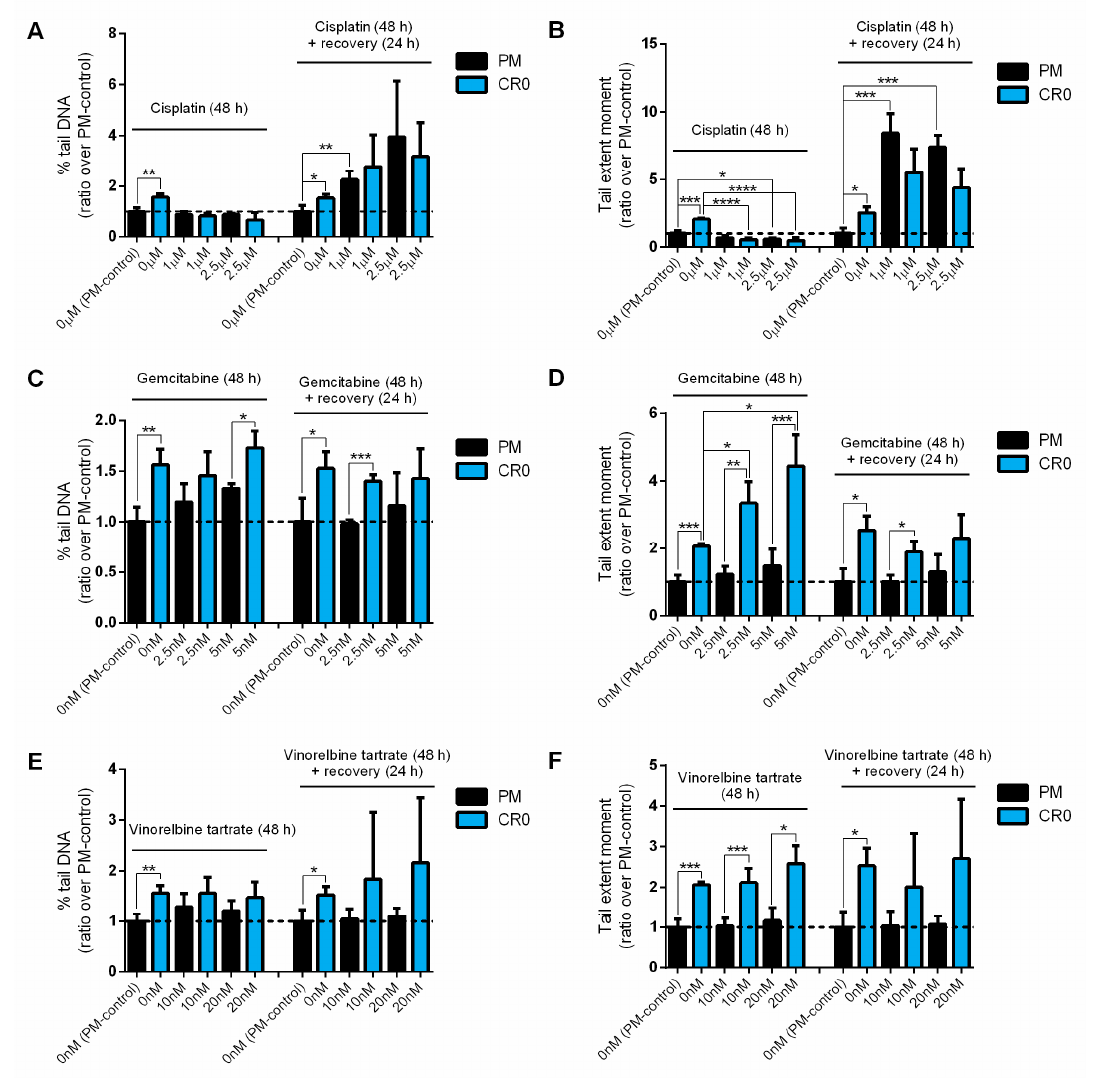
Figure 6. DNA damage and repair capacity of PM and CR0 cells exposed to selected chemotherapeutic drugs. Three drugs were tested: ( A , B ) cisplatin, ( C , D ) gemcitabine, and ( E , F ) vinorelbine tartrate. Cells were treated with two selected concentrations of the above chemotherapeutic drugs for 48 h and their DNA damages were measured by comet assay directly or after a 24 h recovery period. Two DNA damage parameters are shown: (A,C,E) % tail DNA and (B,D,F) tail extent moment. Results shown are ratio over untreated PM-control. Error bars represent mean ± SD of three separate experiments. Dash line on the y -axis represents ratio value of PM-control at